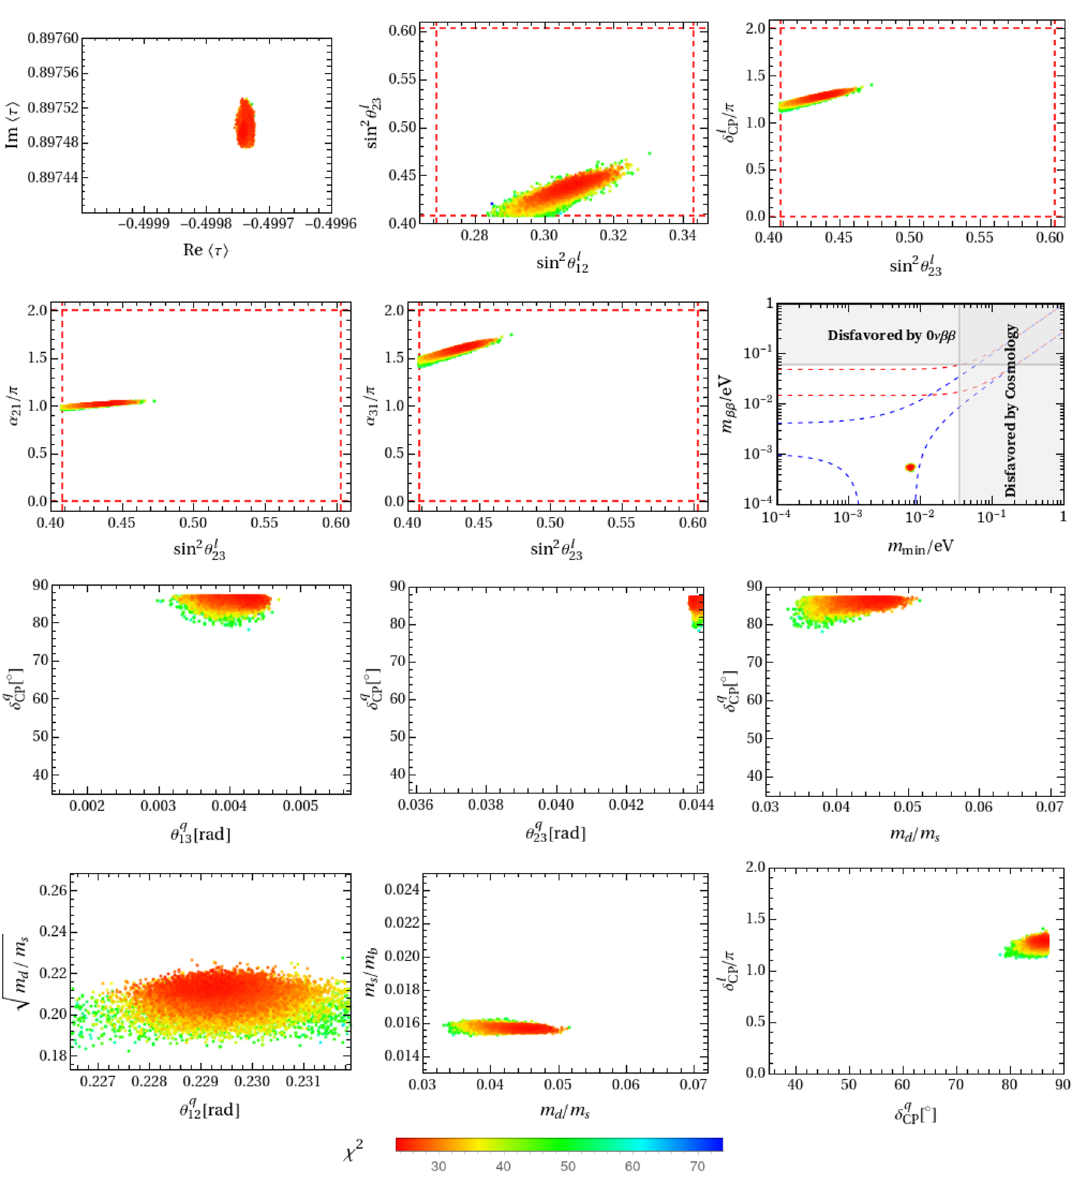
Figure 8 . The values of the complex modulus τ compatible with experimental data and the correlations between the neutrino mixing angles, CP violation phases, quark mass ratios and mixing parameters for the model BM2 with thermal initial condition. The vertical and horizontal dashed lines are the 3 σ bounds taken from [110]. Note that the contribution of Y B to χ 2 is not included